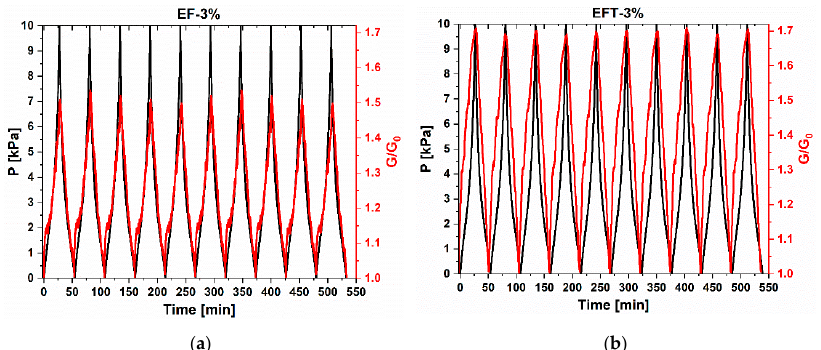
Figure 11. Normalized conductance vs. pressure and corresponding polynomial fitting curves obtained at a speed of 0.1 ( a ) and 1 ( b ) mm/min for the EFT-3% sample.